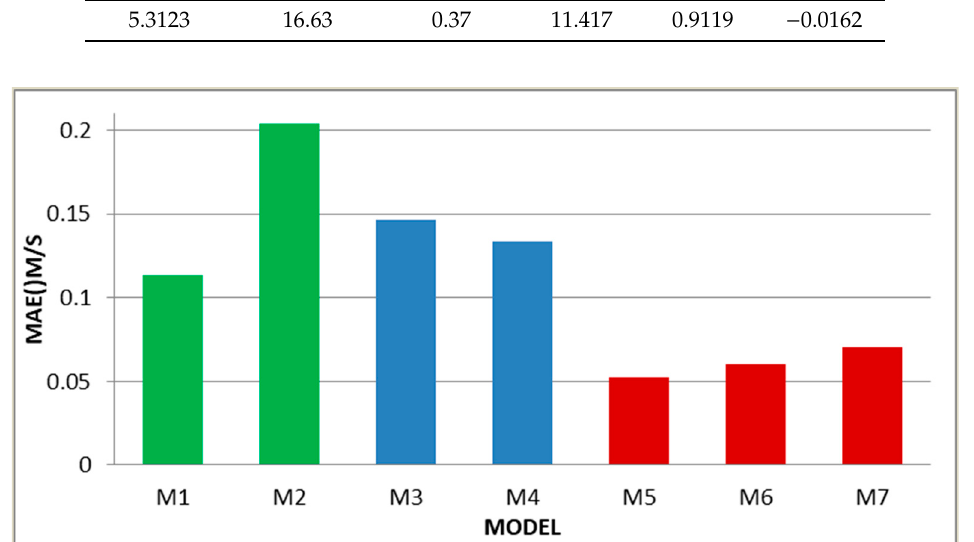
Figure 6. The comparison chart of mean absolute error (MAE).